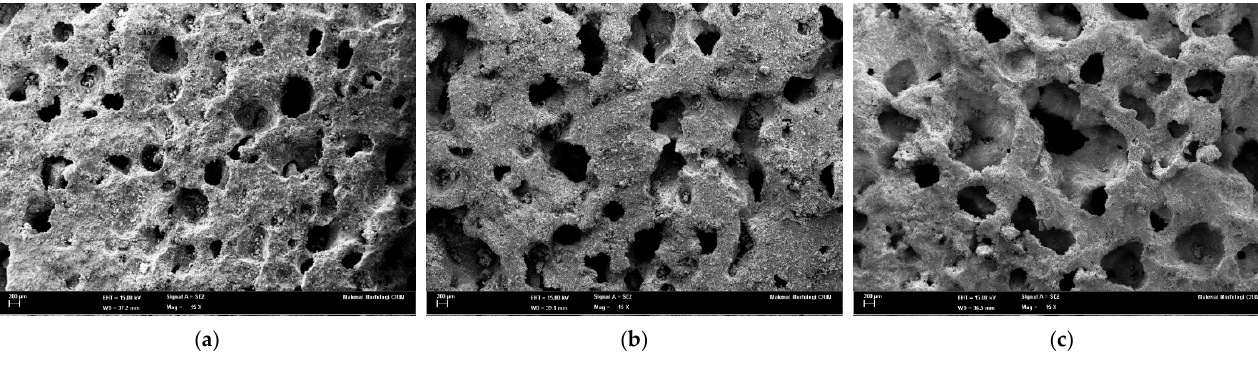
Figure 9. FESEM micrographs of AAC-R30 ( a ), AAC-R50 ( b ), and traditional AAC ( c ) at 200 µm.